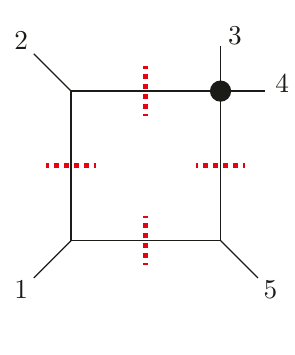
Figure 3 . The quadruple cut can be solved and the solutions plugged into the pinched propagator to give c 4